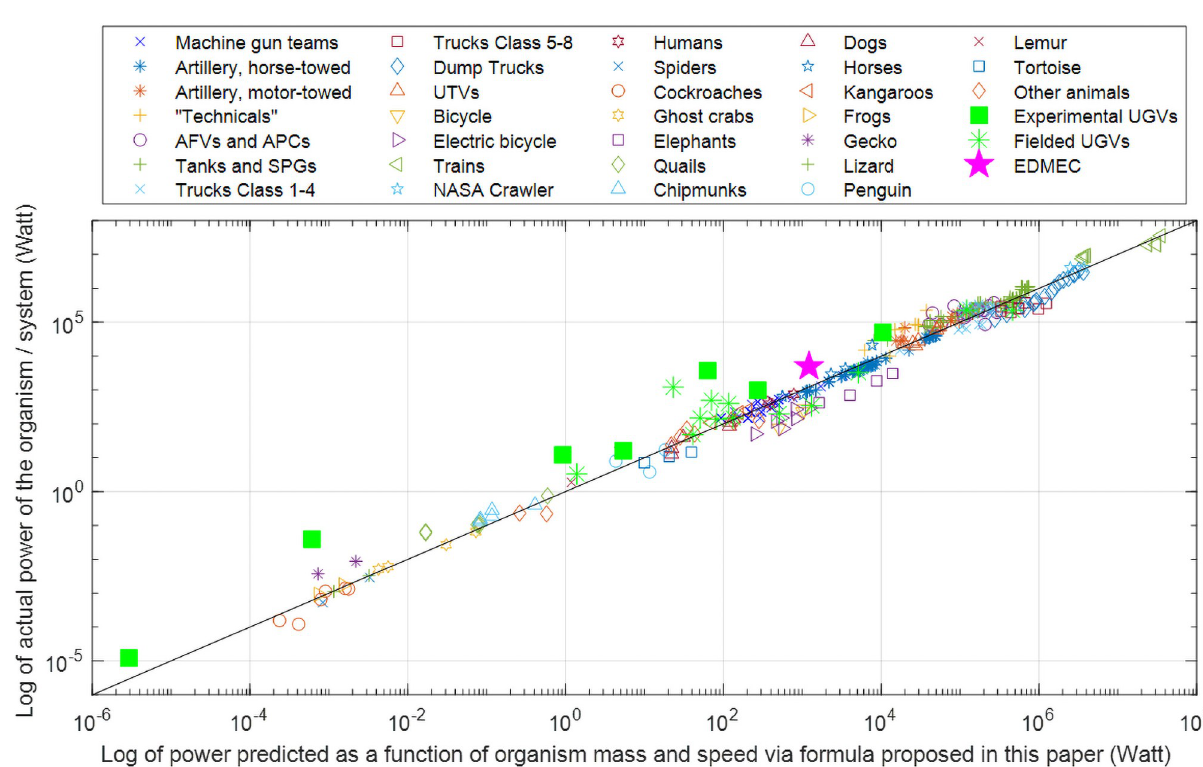
Fig 4. Fielded and experimental robotic systems —L egged, tracked, and wheeled —C ompared with the data in Fig 3.